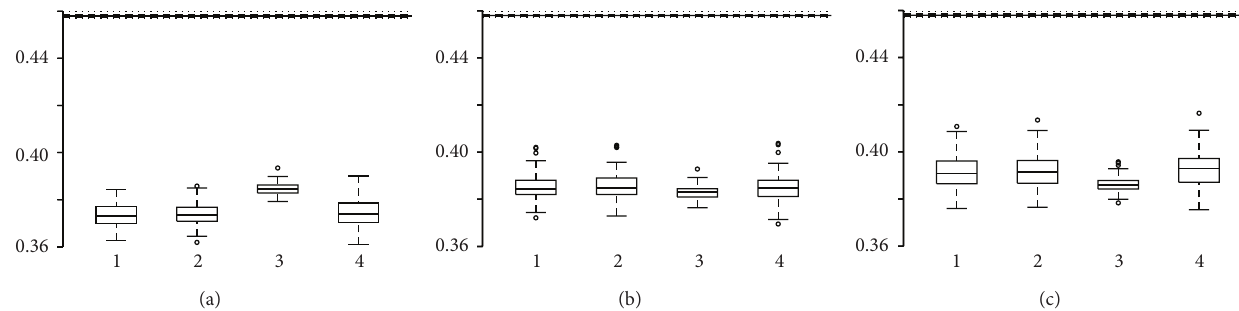
Figure 3: Boxplots of the 100 RMSE of the models predicting the occurrence probability of stagnic properties. (a) 10m terrain resolution, (b) 20 m terrain resolution, and (c) 30 m terrain resolution. 1 = default Random Forest parameters, 2 = additional predictor selection, 3 = 1, 2+ tuning of sampsize, and 4 = 1, 2+ tuning of mtry. The lines refer to the boxplot parameters of the RMSE distribution of the mean of the data as prediction model. Solid line: median, dashed line: upper/lower hinges, and dotted line: upper/lower whiskers.